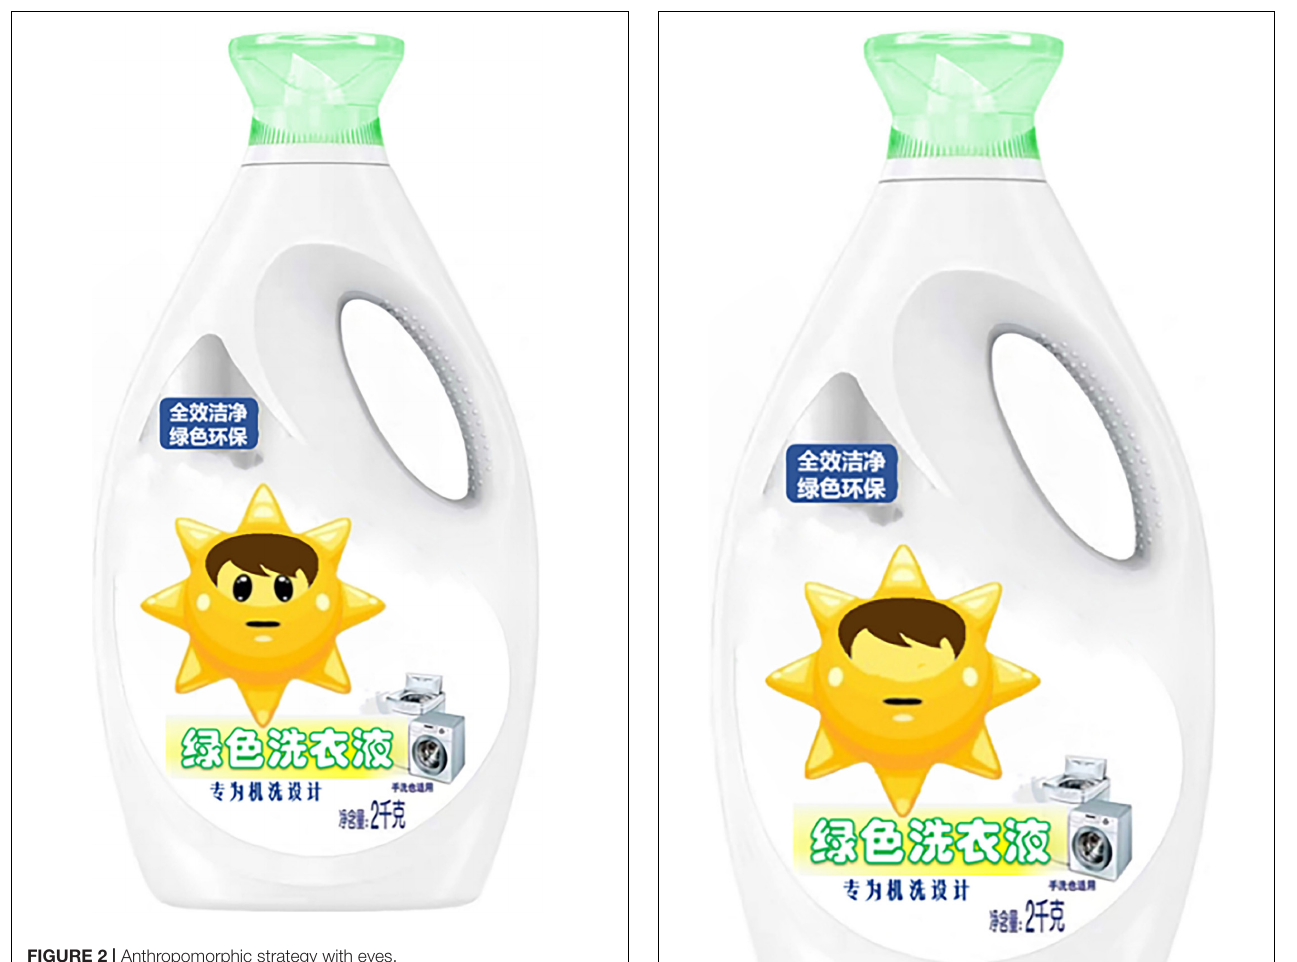
FIGURE 2 | Anthropomorphic strategy with eyes.